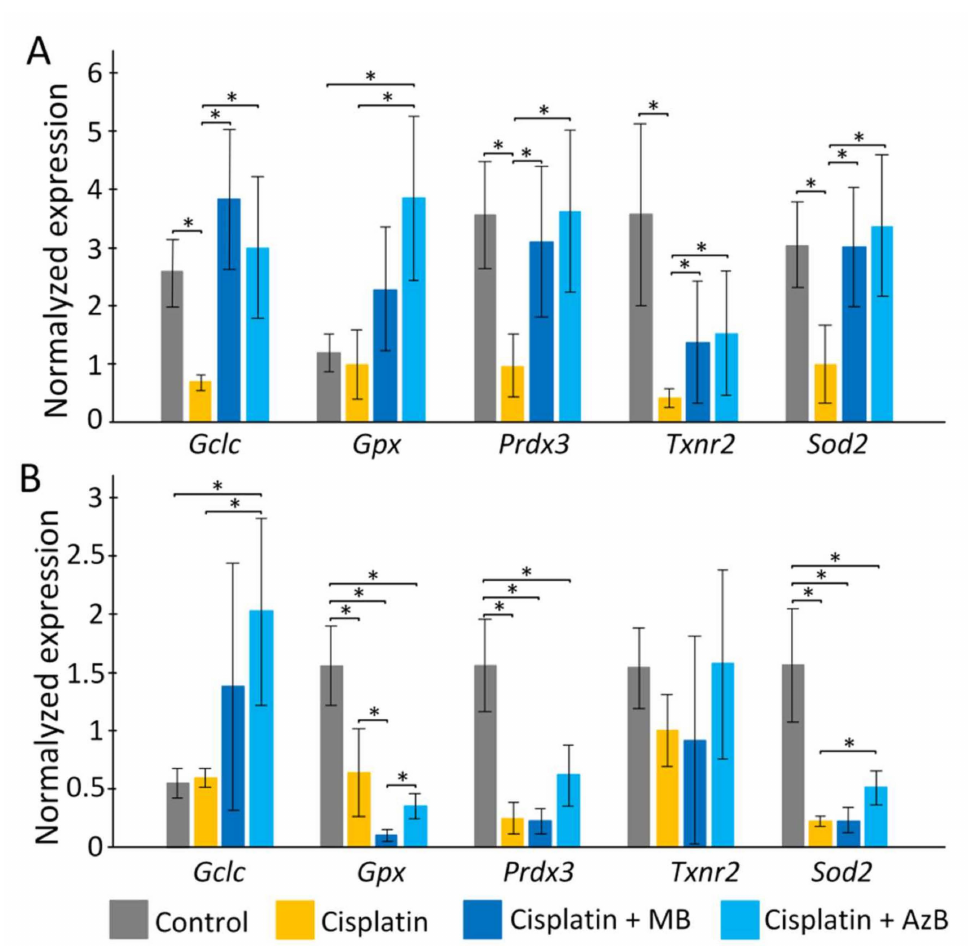
Figure 5. Expression of antioxidants in the ( A ) cortex, ( B ) hippocampus. The results expressed as means ± SEM. Control n = 11, Cisplatin= 6, Cisplatin + MB = 8, Cisplatin + AzB = 8. * p < 0.05, comparison of the control group and treated groups using Tukey’s post-hoc